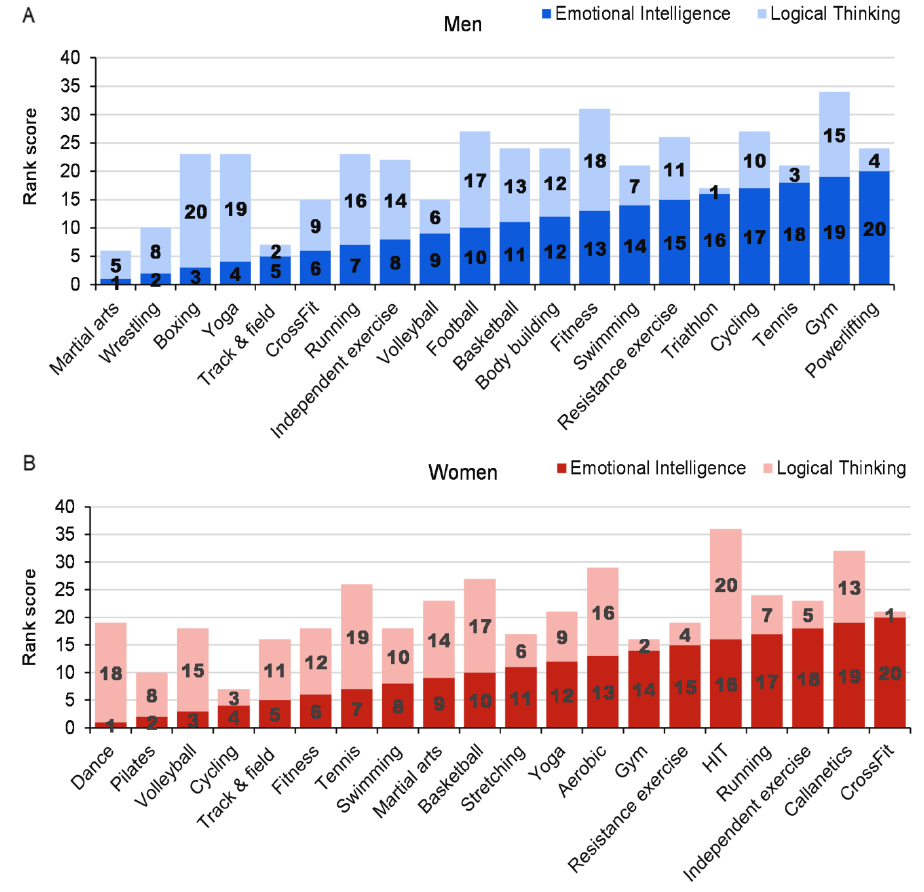
Figure 3. General ranking according to emotional intelligence and logical thinking men ( A ) and women ( B ). Table 6. Relationship between logical thinking and type of exercise in men and